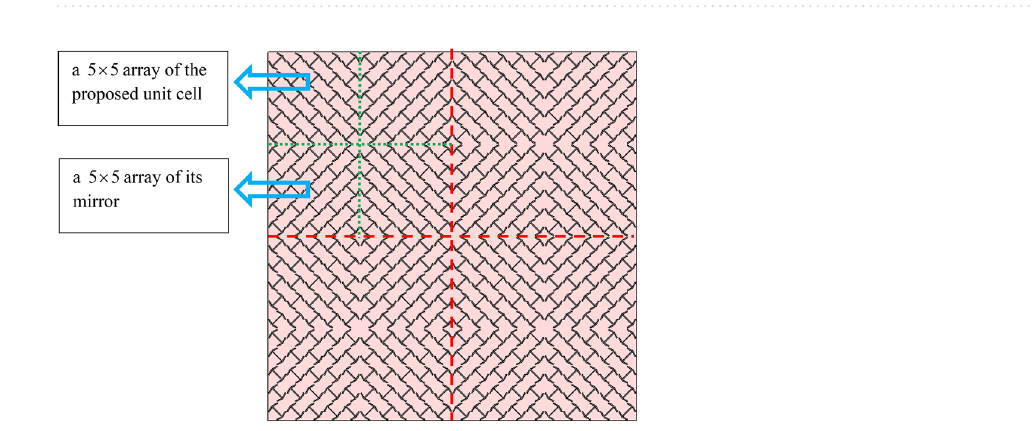
Figure 11. The full structure formed of the proposed unit array and its mirror. (The H-shape is on the back of the substrate and is not